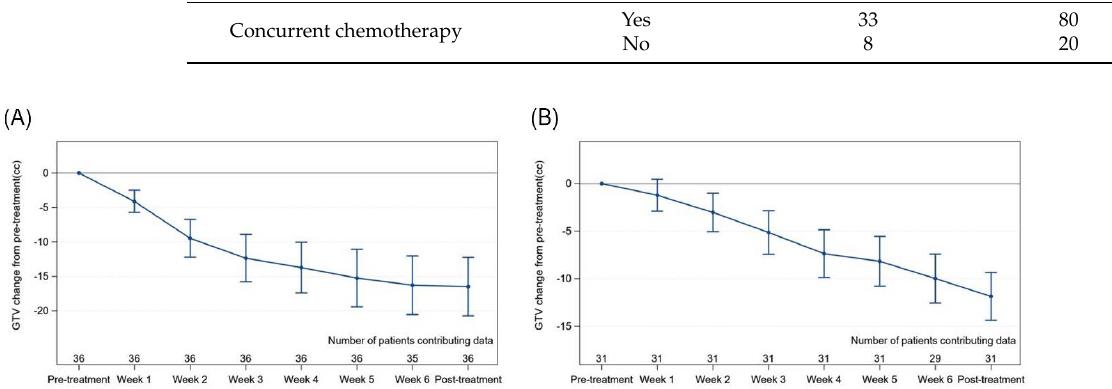
Figure 1. Mean change in primary tumour ( A ) and total nodal volume, ( B ) and from pre-treatment volume to each timepoint with 95% confidence interval. Abbreviation: GTV — gross tumour volume.